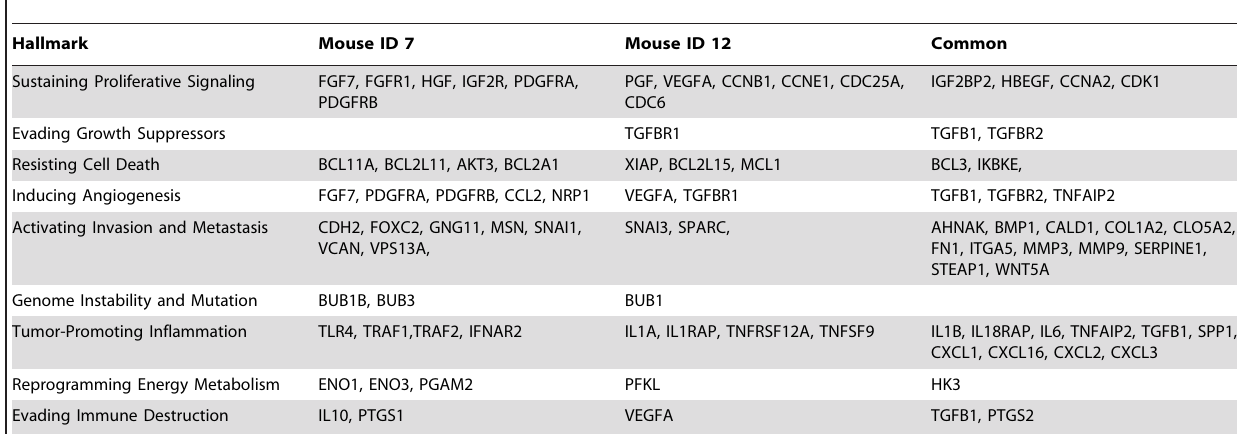
Table 3. Heterogeneity in cancer hallmarks - Comparison of Mouse ID7 and Mouse ID12.